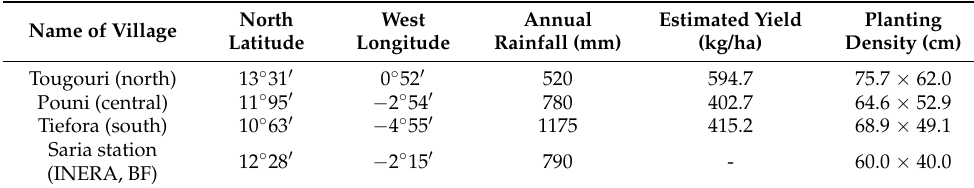
Table 2. Location of base station and target village/region, basic productivity, and planting density at farmers’ fields.